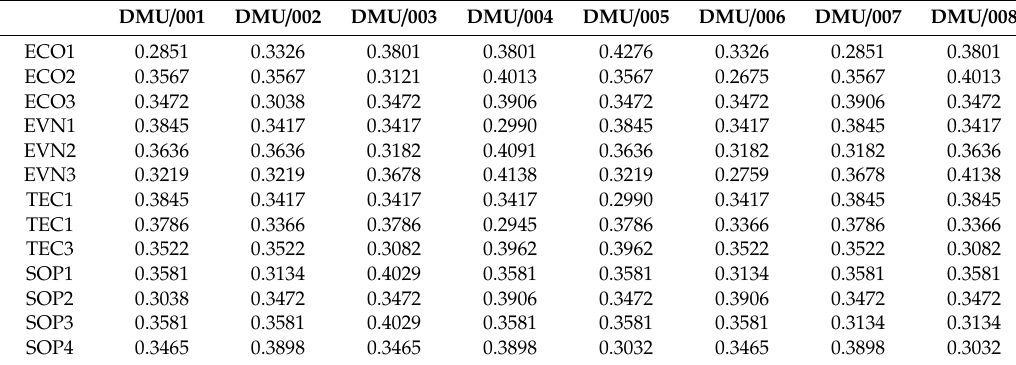
Table 3. Normalized